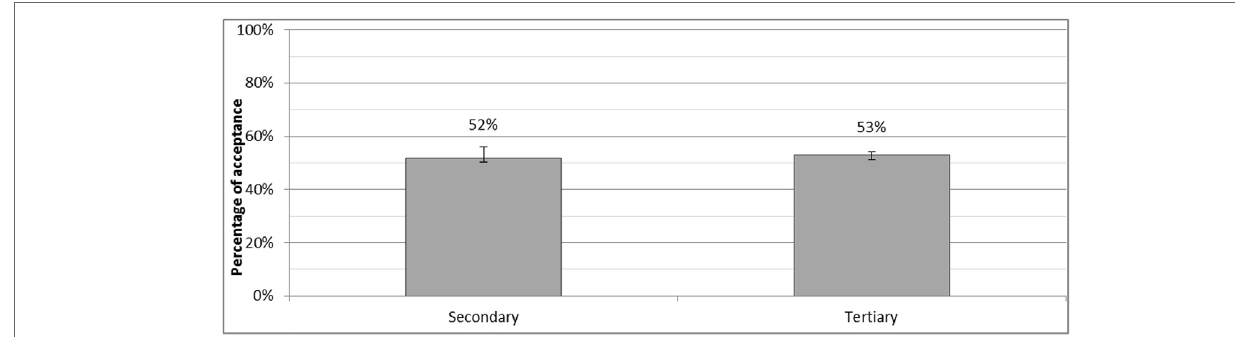
FigUre 3 | Rates of cleft acceptance as a function of education .